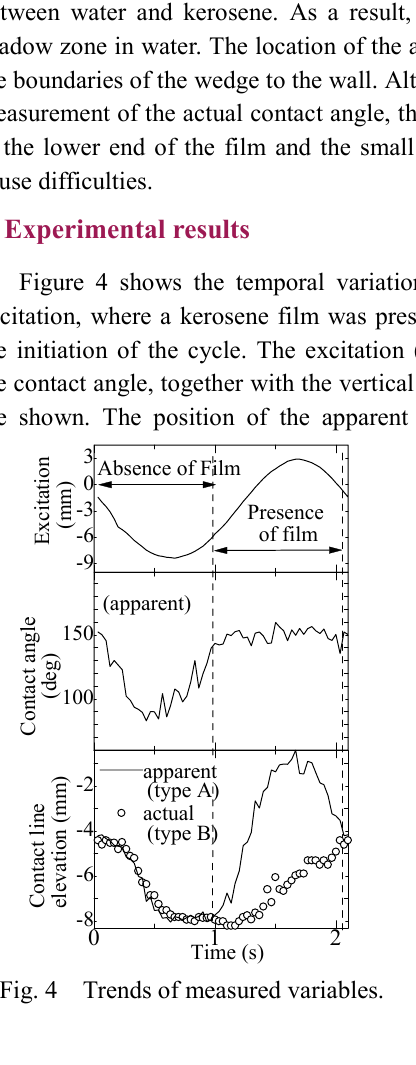
~50 deg. Fig. 2 Measurement setup "A" for interface profile.